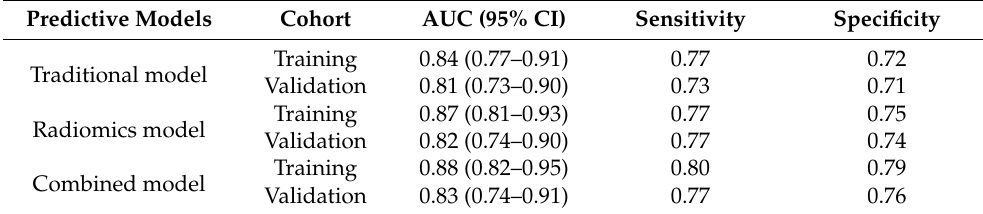
Table 2. Performance of the models in training and validation cohorts.